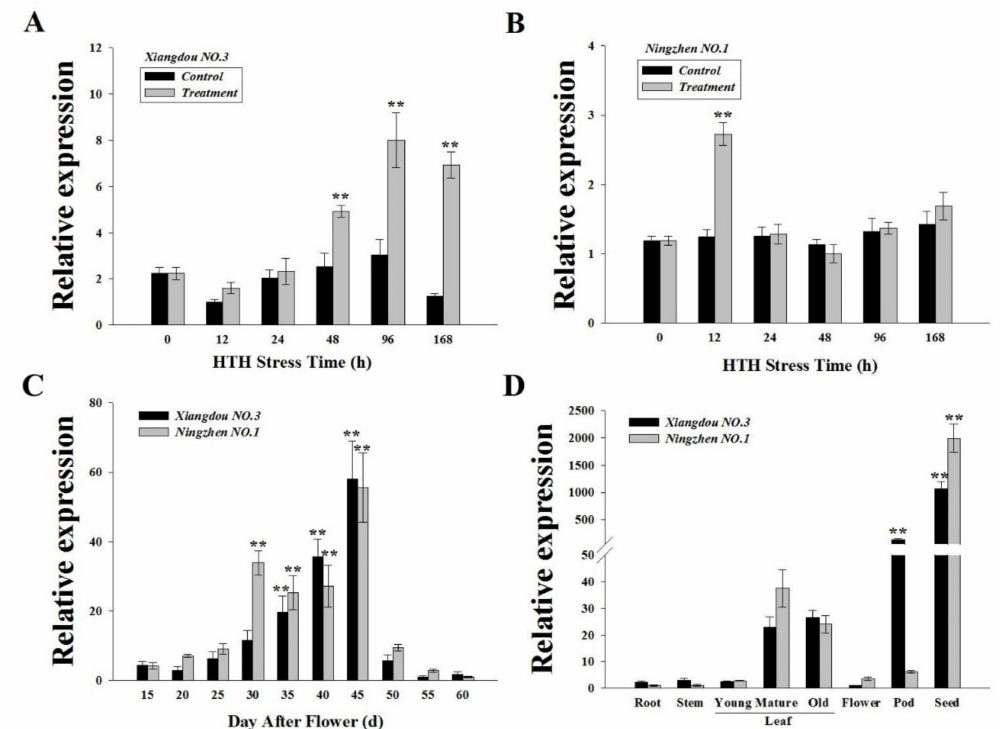
Figure 2. ( A , B ) Transcript level of GmMT-II in Xiangdou No. 3 and Ningzhen No. 1 soybean cultivars in different hour intervals under HTH stress conditions. ( C ) Expression level of GmMT-II in Xiangdou No. 3 and Ningzhen No. 1 soybean cultivars quantified days after flowering. ( D ) Expression level of GmMT-II in different tissues of Xiangdou No. 3 and Ningzhen No. 1 soybean cultivars. Results are shown as mean ± SD for three independent replicates. ** denotes significance at p < 0.01 level, according to Tukey’s correction ( p < 0.01). Scale bars: 1